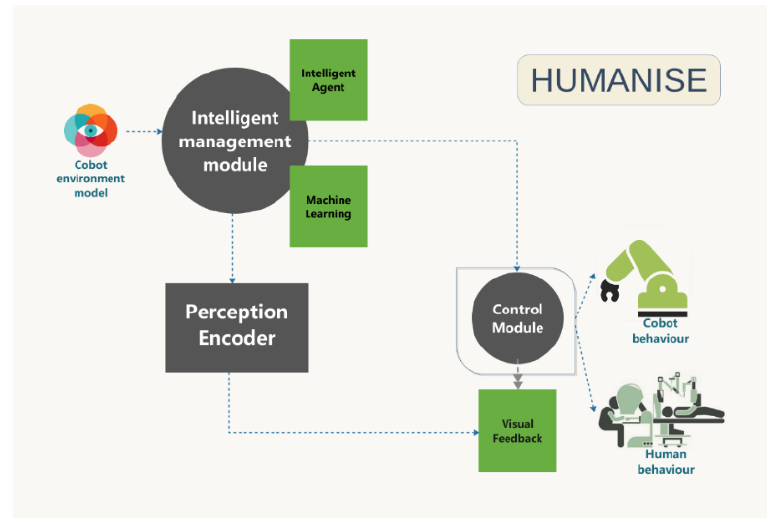
Figure 5. Diagram of the Smart Management System.